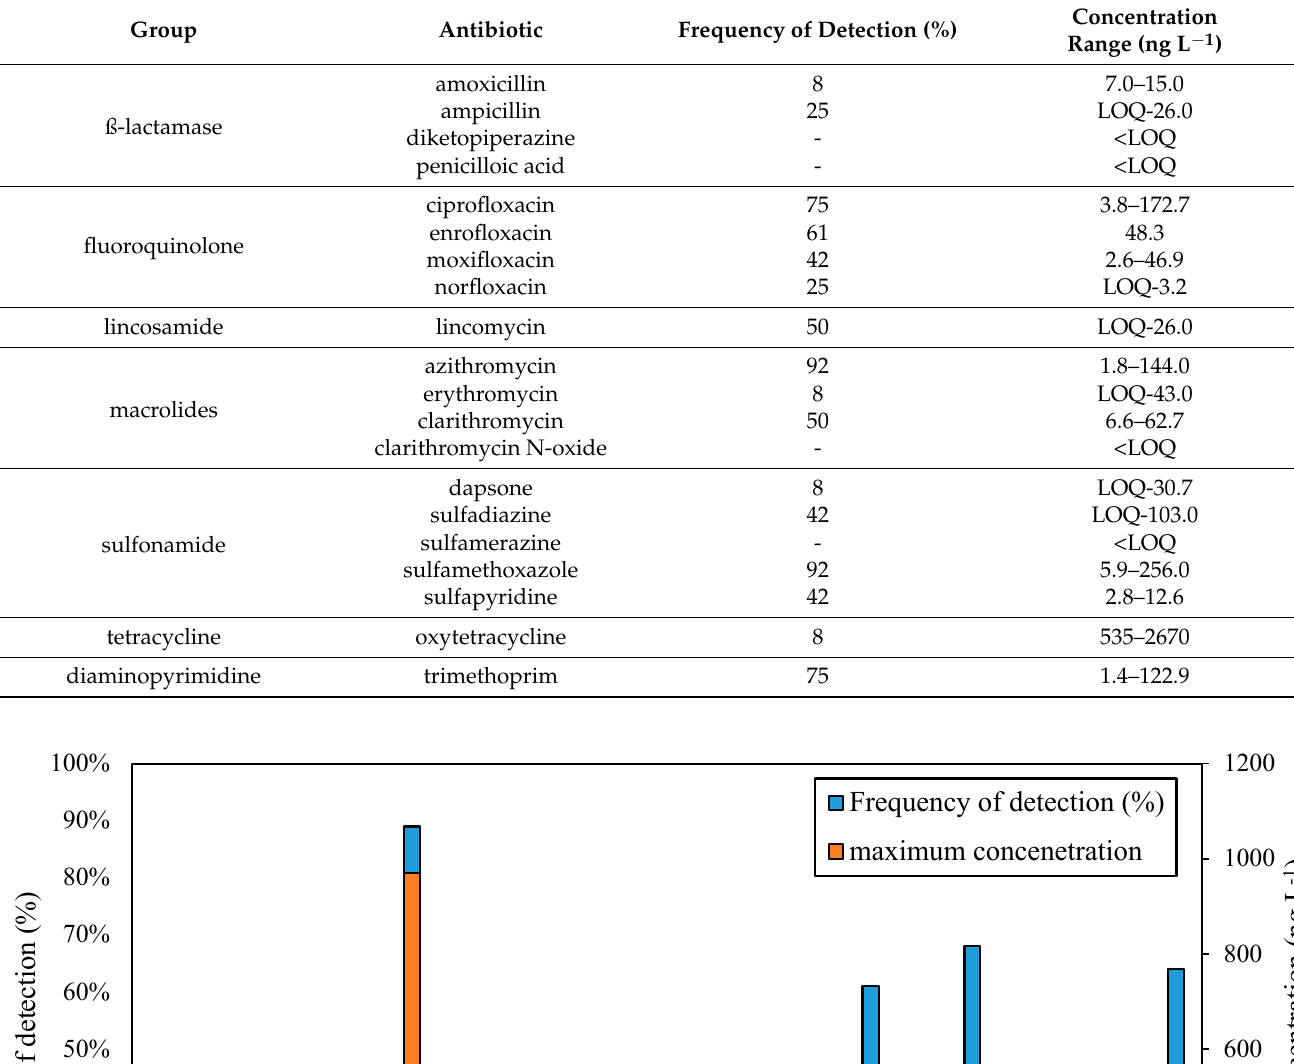
Table 3. Concentrations of antibiotics found in wastewaters.